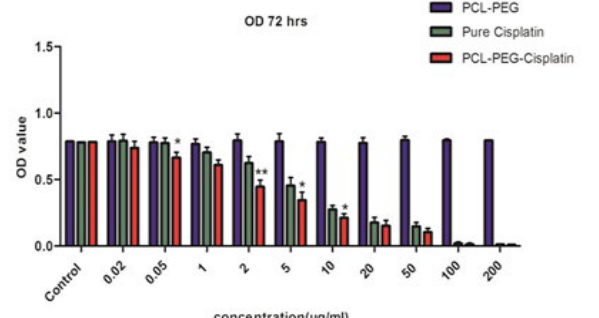
Fig. 5.c: The results of the treatment cells (A